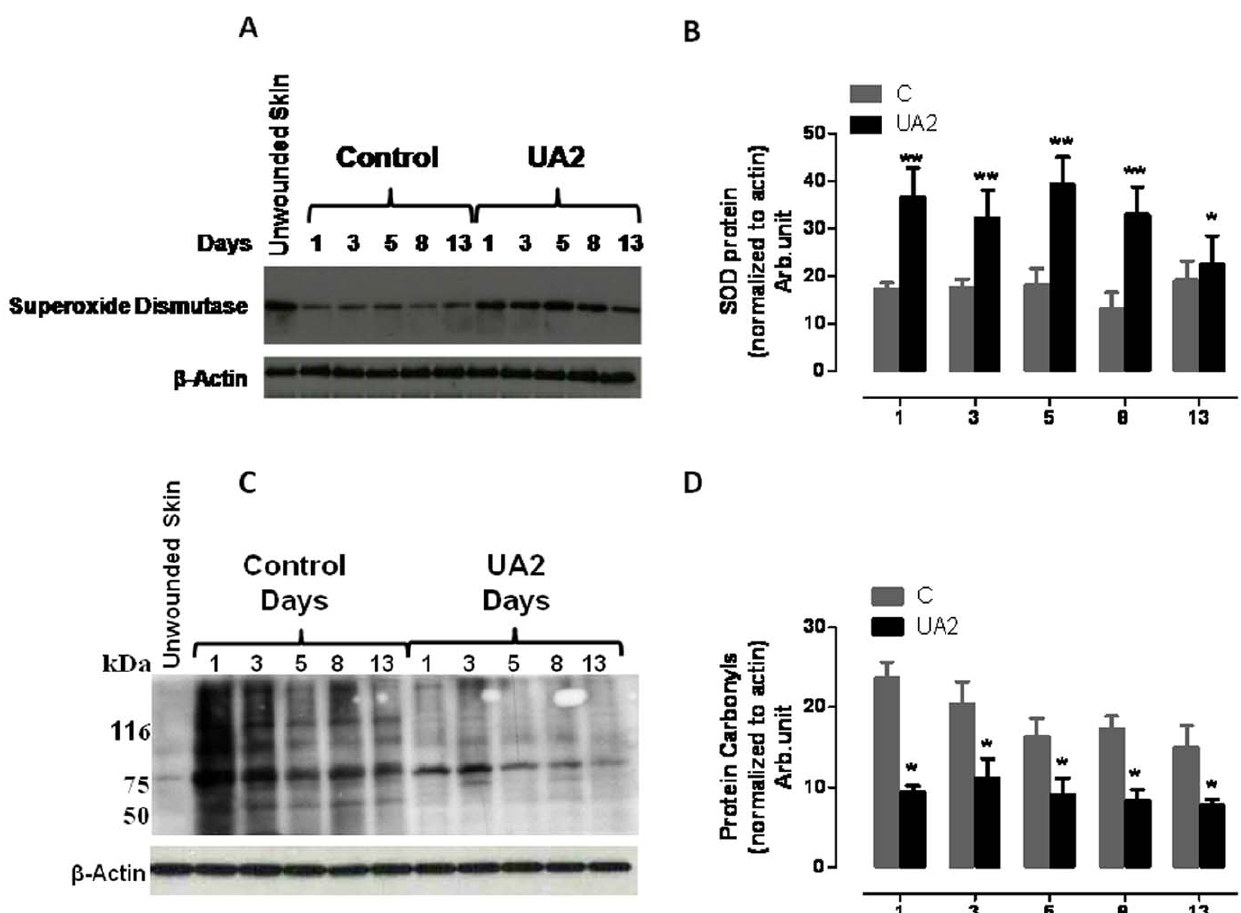
Figure 6. Levels of Cu/Zn superoxide dismutase (SOD1) are increased in wound tissue from mice treated with UA2 (n=4). A. Mice were treated with vehicle (control) or UA2 for the indicated number of days post-injury along with unwounded skin tissue. Wound tissue samples were then removed and were subjected to immunoblot analysis (40 m g protein/lane) using antibodies to SOD1, and actin (44 kDa). B. Densitometric analysis of band intensity (Image J, NIH) of immunoblots showed a significantly increased level of SOD in the skin tissue at 1, 3, 5, 8, 13 days in UA2 treated mice compared to control mice. * P , 0.01 compared to values for each of the other groups. Statistical comparisons were made using ANOVA with Newman-Keuls post hoc tests for pair wise comparisons using GraphPad Prism version 5.00 for Windows, GraphPad Software, San Diego California USA, www.graphpad.com. C. Enhanced oxidative stress in control wound tissues compared to UA2 treated at days 1,3,5,8 and 13. Lysates (20 m g of total protein) were analyzed for the presence of oxidized proteins by oxyblot analysis. The membrane was re-probed with an antibody to b - actin (n=4). D. Densitometric analysis of band intensity (Image J, NIH) of oxyblot showing significant decrease in carbonyl protein groups in UA2 treated group, ** P , 0.01, * P , 0.05. non fat dry milk in TBST and incubated with Rabbit anti-DNP antibody (1:1000) at 4 u C overnight. The membrane was washed three times and then incubated with secondary antibody goat anti- rabbit IgG, HRP-conjugate (1:3000) for one hour at room temperature and then washed with TBST. The oxidized proteins were detected by chemiluminescence (ECL Thermoscientific).